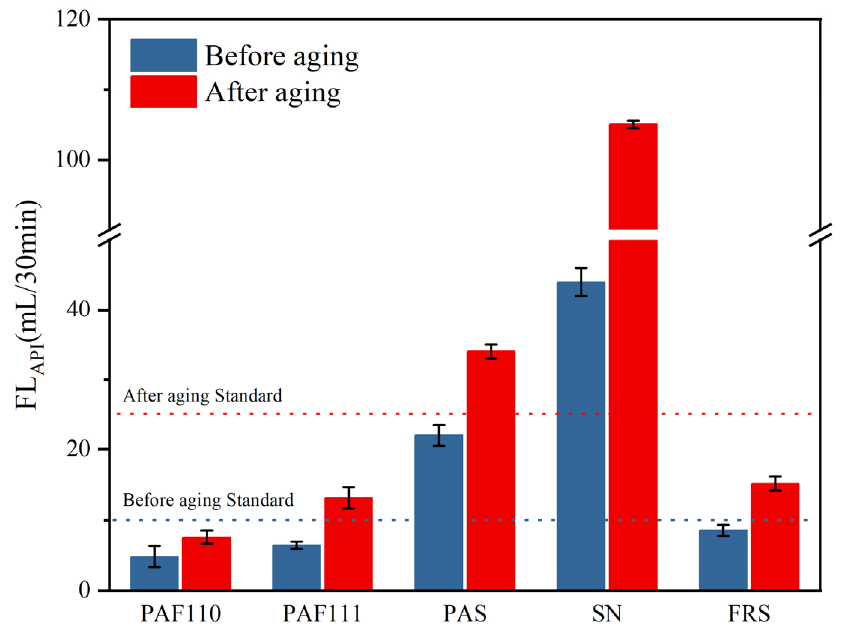
Figure 9. The FL API of all samples before and after aging.